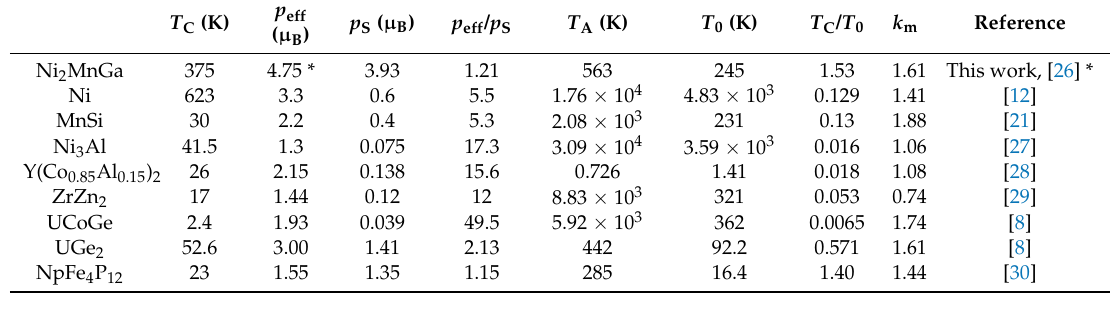
m , as obtained from Equation (10).